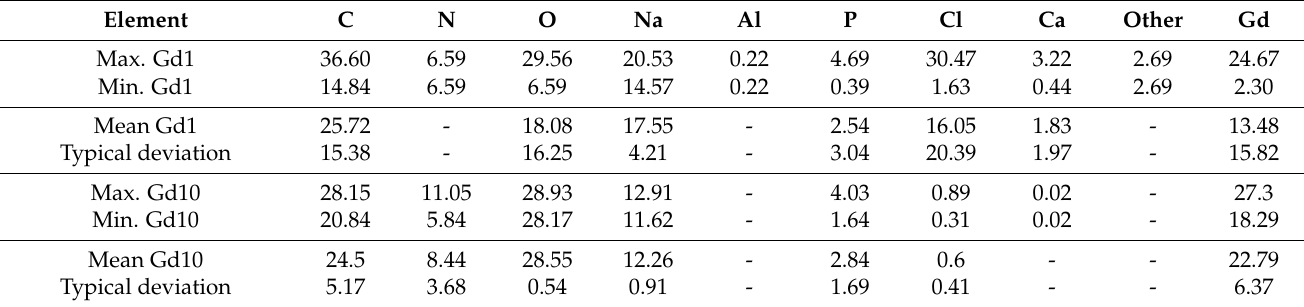
Table 3. Statistical treatment for quantitative elemental